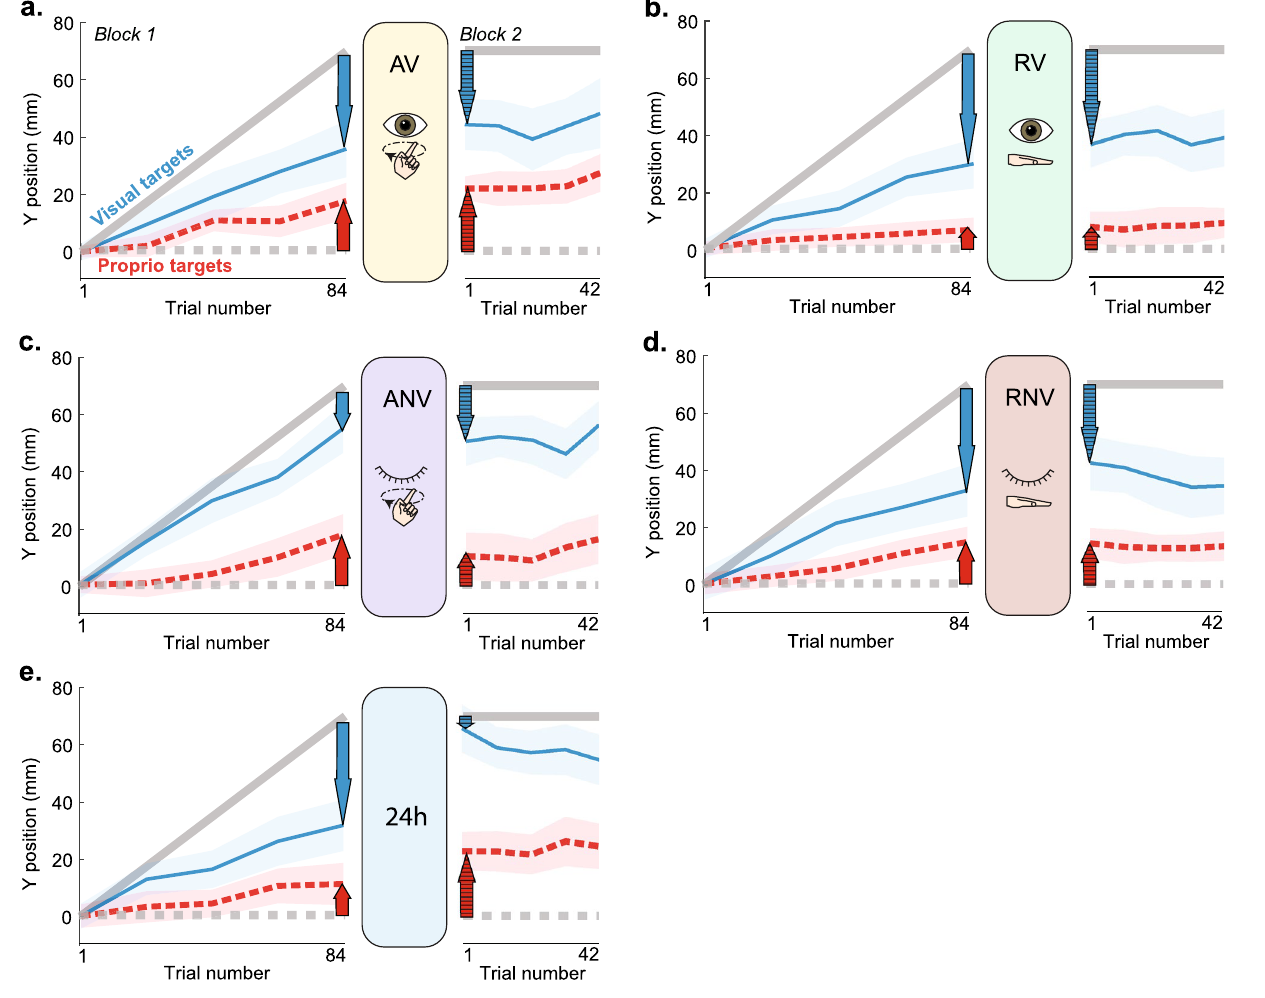
Figure 3. Mean task performance within groups. Blue line represents group mean estimates of V targets. Red line represents group mean estimates of P targets. Shaded regions represent SEM. ( A )–( D ) For the active and rest, vision and no vision groups, retention (cross-hatched arrows) appears similar in magnitude to recalibration (solid arrows) for each modality, with small variations. ( E ) For the 24 h group, visual retention is smaller than visual recalibration, while proprioceptive retention appears larger than proprioceptive recalibration. X-axis values indicate total number of individual trials elapsed, including P, V, and VP, but only P and V data is plotted for